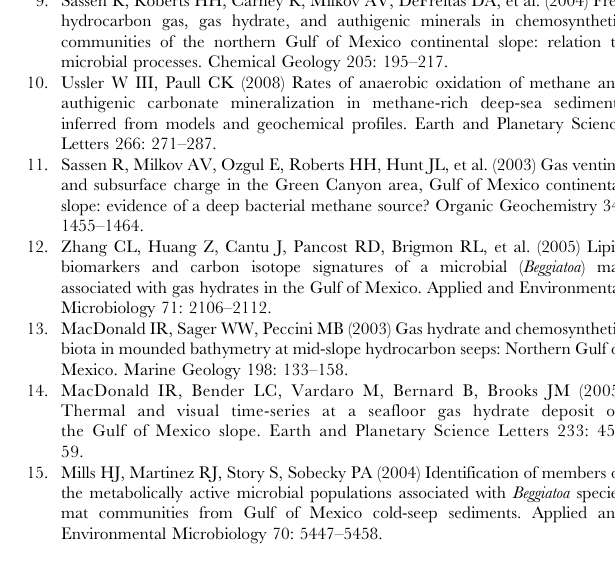
Table S1 Comparison of depth-integrated sulfate reduction and methane oxidation rates (mmol m-2 d-1) to concentrations fluxes of sulfate and methane (mmol m-2 d-1), respectively. Table S2 Primer sequences used in the study, their annealing temperatures, target groups, and known mismatches. Figure S1 Model fit to sulfate concentration data (red line), or sulfate reduction rate data (blue line) for Edge core. Yellow markers are the data from Figure 2c. Figure S2 Neighbor-joining tree of cDNA of full-length Deltaproteobacterial 16S rRNA sequences for all samples. The nodes are labeled with parsimony-based boostrap values (1000 repetitions) that were over 60%. OTUs are based on 98% similarity. Sequences from dive 3570 are in colors corresponding to those of Fig. 3a groupings. Clones given their core name (either MatB, Edge, or Out) followed by the beginning of their depth interval (0–3 cmbsf, 12–15 cmbsf, or 21–24 cmbsf), the type of cDNA (arc or bac for archaeal or bacterial 16S rRNA, mcr or dsr for mRNA), and a unique clone number. The number of sequences included in each OTU are in parentheses after the clone name, with the core and depth listed.